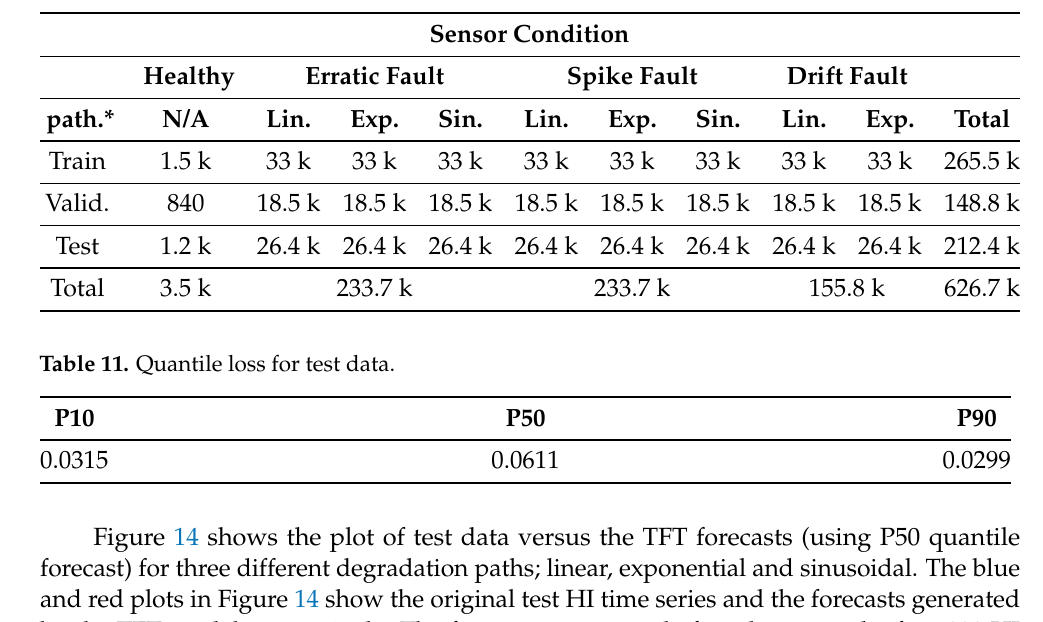
Table 10. Number of data-points in HI time series for train, validation and test of the TFT model. *path. stands for degradation path.